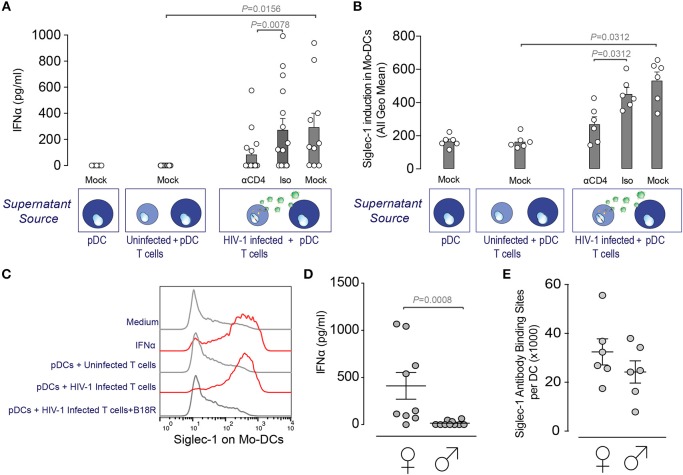
pDCs exposed to HIV-1 induce Siglec-1 expression on DCs via IFNα secretion. (A) IFNα release measured by ELISA on supernatants from blood derived pDCs co-cultured 24 h alone, with an uninfected MOLT CD4+ T cell line or an HIV-1 infected MOLT CD4+ T cell line that chronically produces R5-tropic BaL viruses in the presence or absence of 10 μg/ml of an anti-CD4 or an isotype mAb. Bar graph shows mean values and SEM from at least 6 donors and 3 independent experiments. Statistical differences were assessed with a Wilcoxon matched-pairs signed rank test. (B) Induction of Siglec-1 on monocyte-derived DCs incubated with supernatants isolated from pDCs co-cultured as in (A) and assessed by FACS. (C) Representative histograms of Siglec-1 expression on monocyte-derived DCs exposed to medium, recombinant IFNα, supernatants from uninfected pDCs, supernatants from HIV-1-exposed pDCs on mock treated DCs or on DCs previously incubated with the type-I interferon blocking receptor B18R. (D) IFNα release measured by ELISA on supernatants of pDCs isolated from women or men and co-cultured 24 h with an HIV-1 infected MOLT CD4+ T cell line. Bar graph shows mean values and SEM from 19 donors and 4 independent experiments. Statistical differences were assessed with a Mann-Whitney test. (E) Quantification of Siglec-1 expression levels on monocyte-derived DCs from men and women assessed by FACS. Bar graph shows mean values and SEM from 12 donors and 3 independent experiments. Prentice Rank Sum Test was used to assess statistical differences, which did not reach statistical significance (P = 0.073).